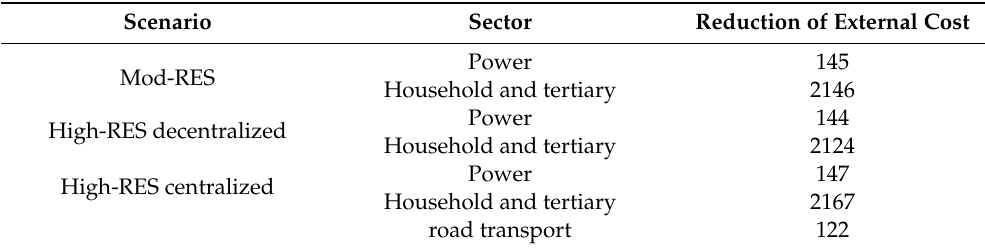
Table 5. The reduction of external cost between base year 2015 and 2050 according to the results of implementation of scenarios for considered sectors (M €